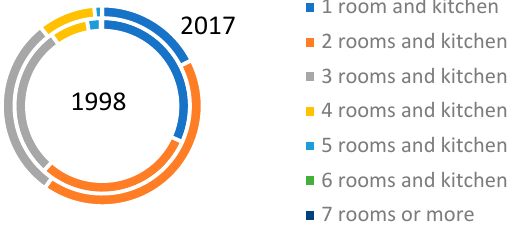
Figure 3. Apartments in new construction by type in Stockholm region in 1998 and 2017.